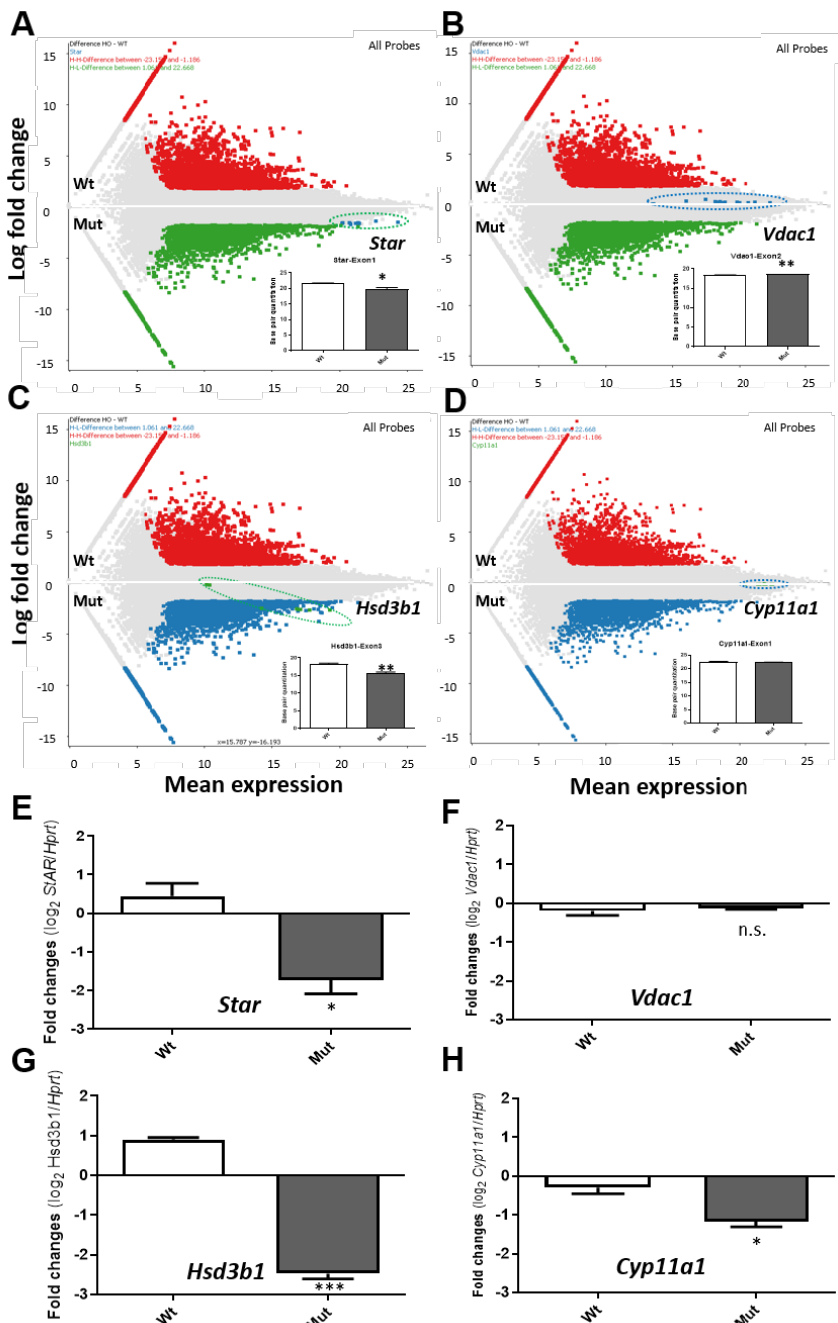
Figure 2. MA-plots of RNA-Seq data for selected important steroidogenic genes: Star ( Stard1 ), Vdac1 , Hsd3b1 , and Cyp11a1 . ( A ). Exons of Star are shown as blue dots, and the bar graph shows quantitation of the actual number of bases between Mut versus Wt. ( B ). Exons of Vdac1 gene are shown as blue dots, and the bar graph shows the quantitation of the base difference between Mut versus Wt. ( C ). Exon of Hsd3b1 gene are shown as green dots, and the bar graph shows the quantitation of the base difference between Mut versus Wt. ( D ). Exon of Cyp11a1 gene are shown as green dots, and the bar graph shows the quantitation of the base difference between Mut versus Wt. ( E , H ). Real-time PCR of the four selected genes as shown in ( A – D ). Three steroidogenic genes Star , Hsb3b1 and Cyp11a1 are significantly down-regulated, whereas Vdac1 shows no significant change. *, p value < 0.05 (student t -test, n = 3). **, p value < 0.01 (student t -test, n = 3). ***, p value < 0.001 (student t -test, n =